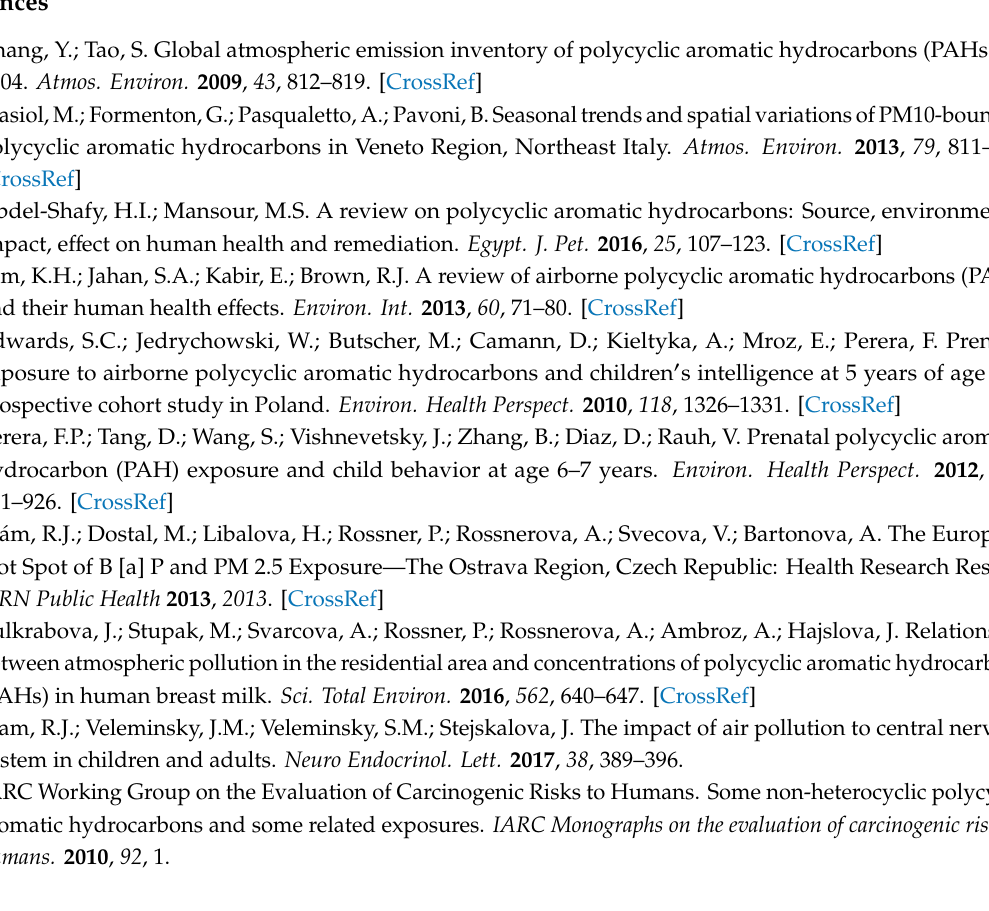
Figure S1: The median concentrations ( ± standard deviation calculated for this study) of BaP, TEQ, FLA and PAH SUM concentrations in the cold half-year (October–March). 2007 stands for winter season 2006–2007 etc. Data till 2006 are from Dvorsk á at al. [5]. The markers are shifted for a better readability, Figure S2: BaP emission production and concentration of BaP and PAH SUM / 10 in the Czech Republic between the years 2006 and 2016 (taken from: [6]), Figure S3: Fuels consumption used for transportation in the Czech Republic between the years 2006 and 2016 (taken from: [7]), Figure S4: Annual cycles of selected PAHs (BaP, TEQ, FLA and PAH SUM) for the years from 2006 to 2016, Table S1: Overall uncertainty and detection limit of measured PAHs (taken from monitoring CHMI), Table S2: Diagnostic ratios, their typical values and characteristic sources (taken from [3,4]), observed trends, together with stat significance level, Table S3: Summary of the mean and standard deviations of BaP and PAH SUM between 1996 and 2016; the BaP and PAH SUM concentrations for 1996–2005 are based on the study of Dvorsk á et al. [5], Table S4: Summary of PMF diagnostics for PAHs composition, Table S5: Diagnostic ratios for PMF factors for warm (W) and cold (C) part of the